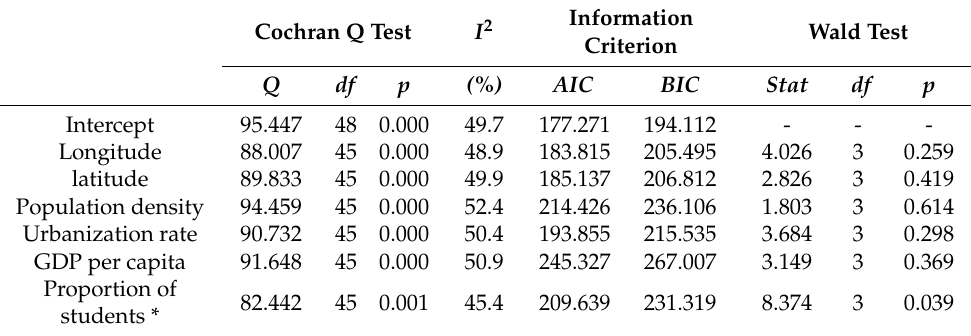
Table 2. The heterogeneity test and Wald test results of the meta-analysis for the effect of daily average temperature on mumps.